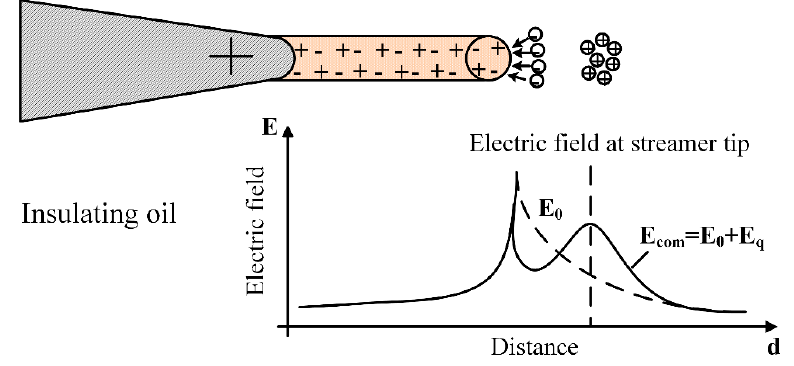
Figure 7. The electric field distribution in insulating oil (E 0 : applied electric field, E q : space–charge electric field).